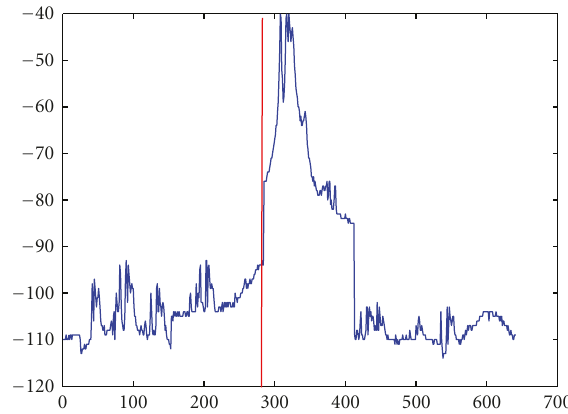
Figure 2: Transient detection from a signal generated by a WLAN transceiver.